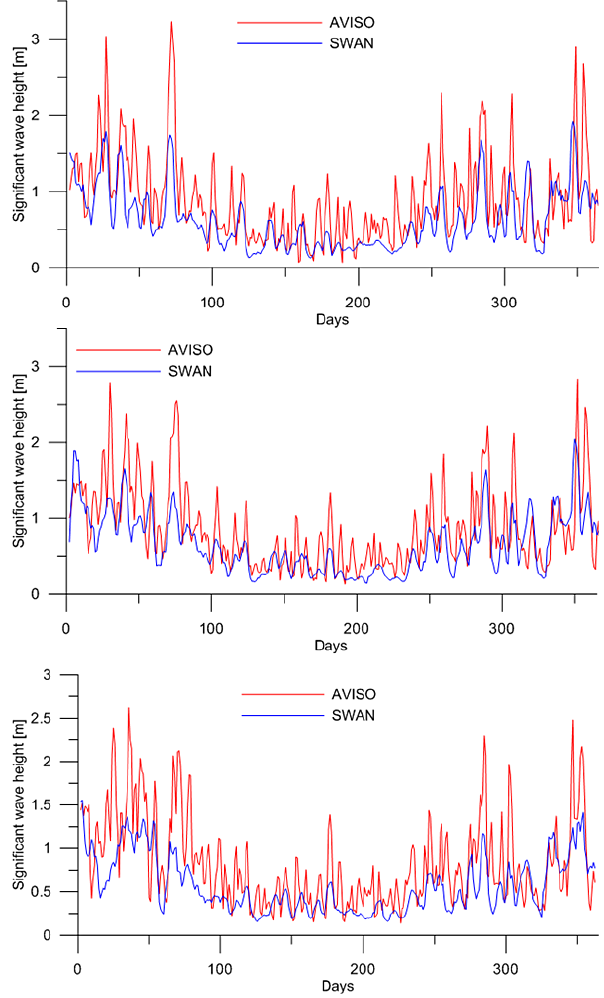
Figure 3. Time series of observed and modelled 5-day average SWH [m] at point 1 (top), 2 (middle) and 3 (bottom).